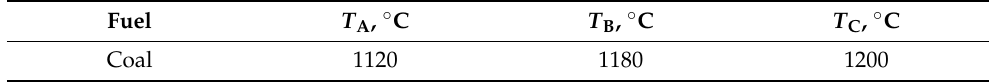
Table 2. Fusibility characteristics of coal ash [35].